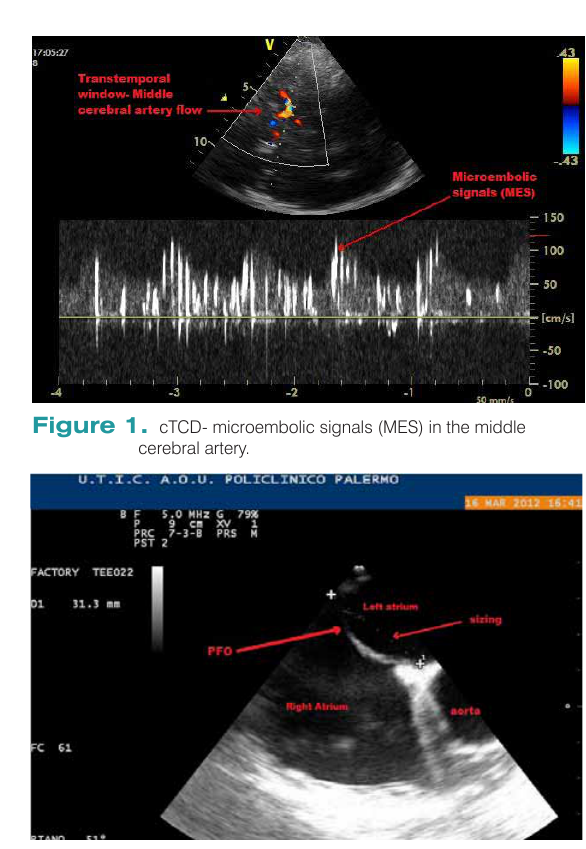
Figure 2. Sizing of the PFO (Transesophageal Echocardiography).